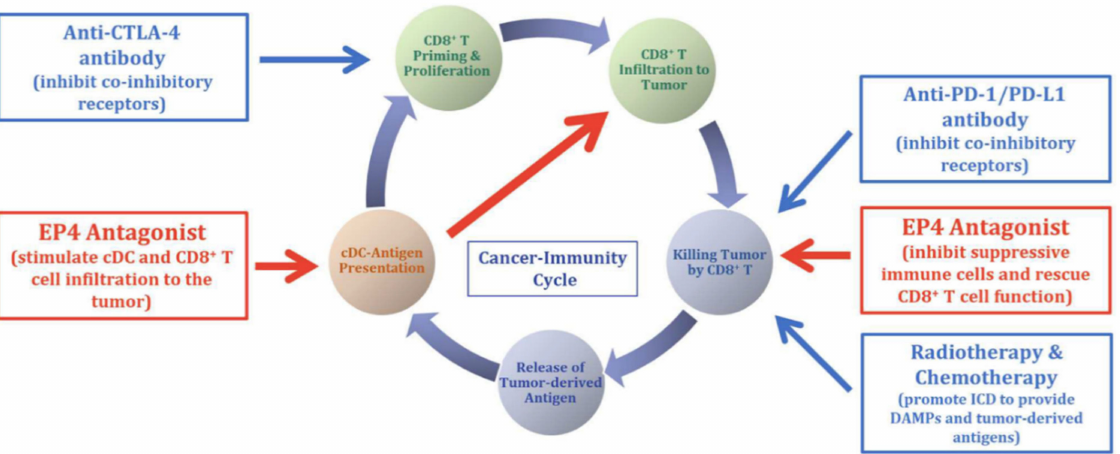
Figure 7. Schema for the rationale of using EP4 antagonists in combination with other therapies, including immune check point inhibitors such as anti-CTLA-4, anti-PD1/PD-L1 in cancer therapy. Red boxes indicate the roles EP4 on tumor-associated T cells. (Reproduced with kind permission from Take et al., 2020)